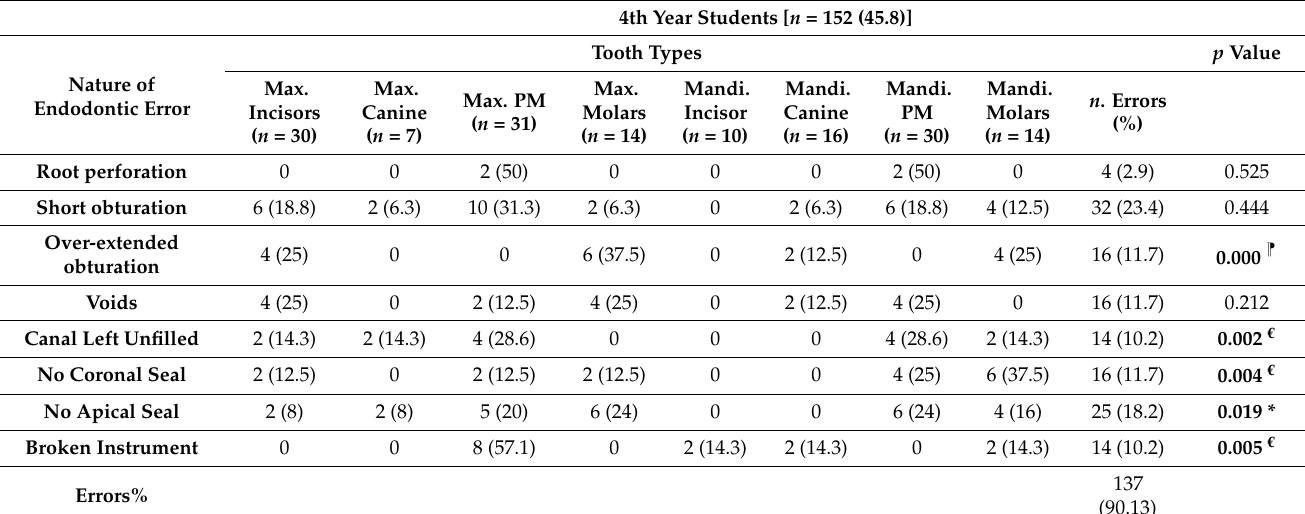
Table 3. The frequency and percentage of errors in RCF performed by 4th year students according to various tooth types.